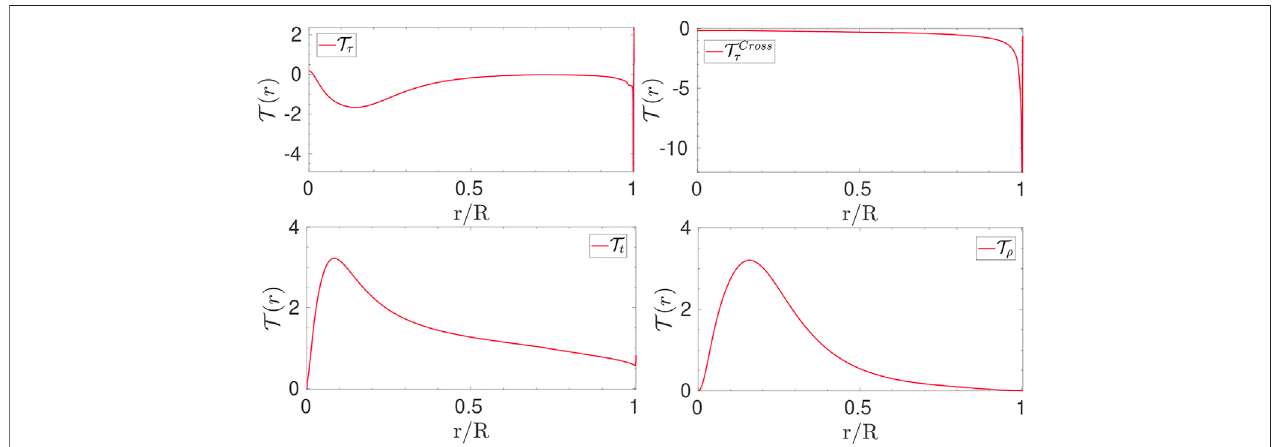
FIGURE 8 | Target functions of various indicators as a function of normalized radius, taken for a model of 16CygA. Upper left and right : target functions for the acoustic radius inversion. Bottom left : target function for the t core condition indicator. Bottom right : target function for the mean